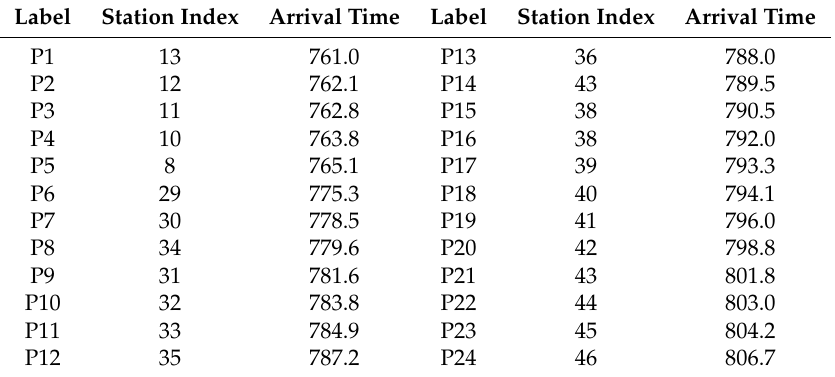
Table 2. The arrival data shown in Figure